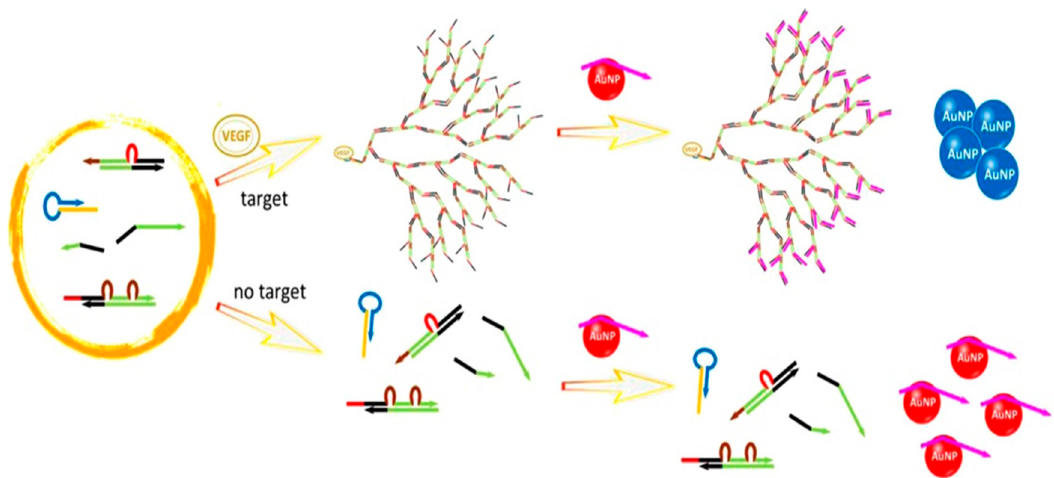
Figure 8. The schematic illustration of target-induced branched DNA cascade reaction and sensing using unmodified AuNPs. Reproduced with permission from Reference [87]. Elsevier B.V., 2016.